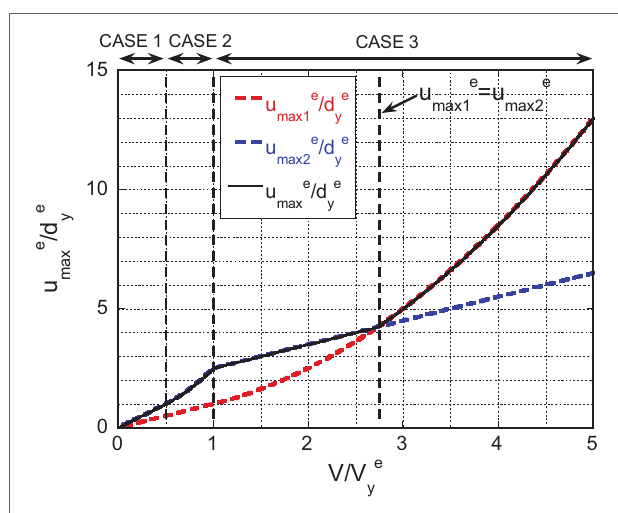
FigUre 7 | Maximum deformation of equivalent sDOF model with respect to the input level normalized for equivalent sDOF model.